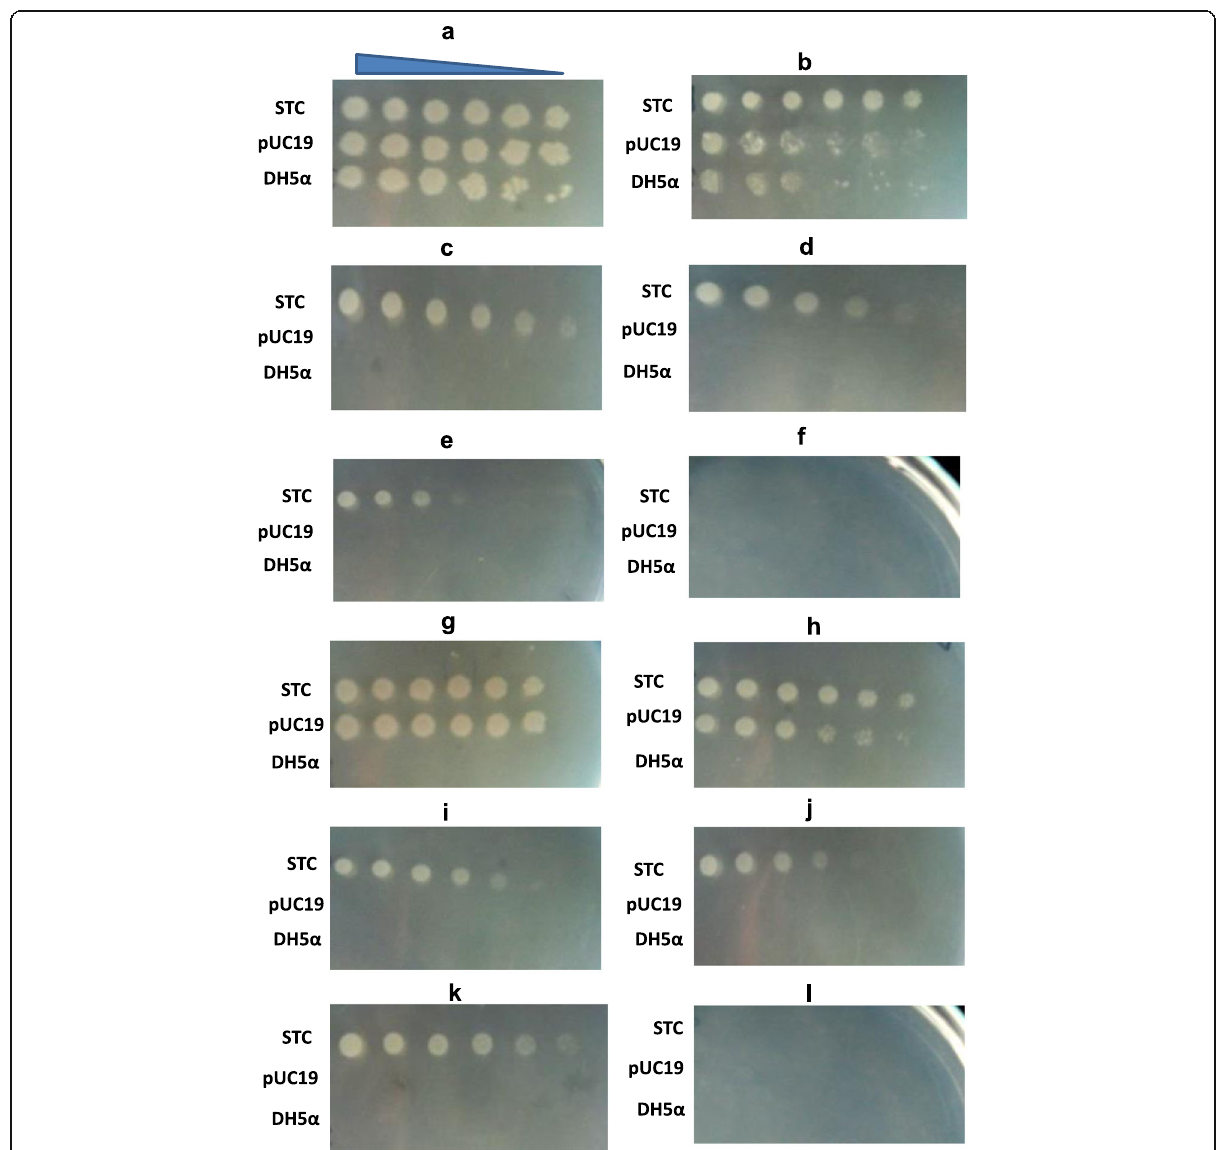
Fig. 1 Growth characteristics of recombinant clone STC. The growth of recombinant clone STC, DH5 α transformed with pUC19, and DH5 α host strain were analyzed for NaCl tolerance in the LB agar medium. A tenfold serial dilution (from left to right as indicated above panel a ) of each strain was spotted on the LB medium ( a – f ) and LB medium containing ampicillin ( g – l ) and increasing concentration of NaCl as follows: 0 ( a , g ), 0.5 ( b , h ), 0.75 ( c , i ), 1.0 ( d , j ), 1.2 ( e , k ) and 1.5 M ( f , l ). The medium without NaCl was used as